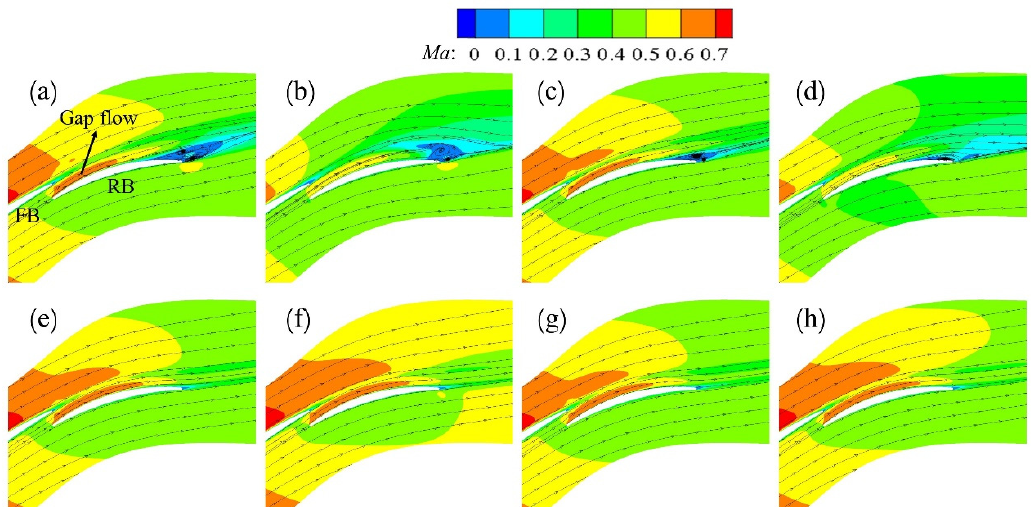
Figure 13. The streamlines and Mach number contours of the tandem cascade at 5% h and 50% h under different IBL conditions: ( a ) 5% h , 0 mm collateral; ( b ) 5% h , 5 mm collateral; ( c ) 5% h , 0 mm skewed; ( d ) 5% h , 5 mm skewed; ( e ) 50% h , 0 mm collateral; ( f ) 50% h , 5 mm collateral; ( g ) 50% h , 0 mm skewed; ( h ) 50% h , 5 mm skewed.